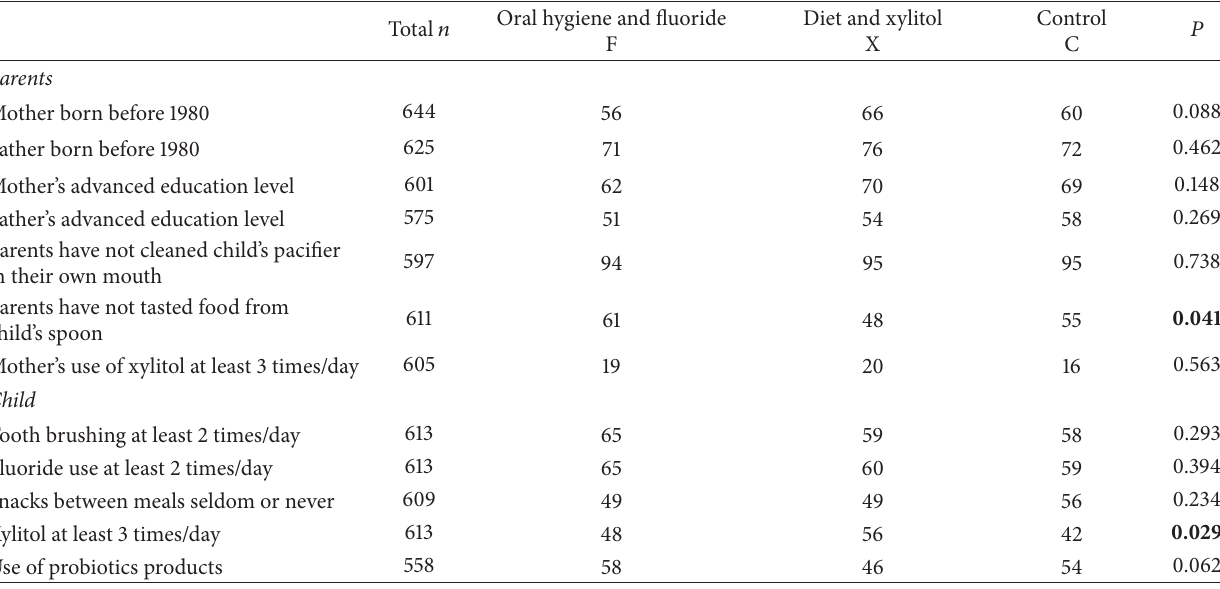
Table 2: Parental background information and child’s reported health habits in first-born children at the age of 24–36 months; percentages within groups.